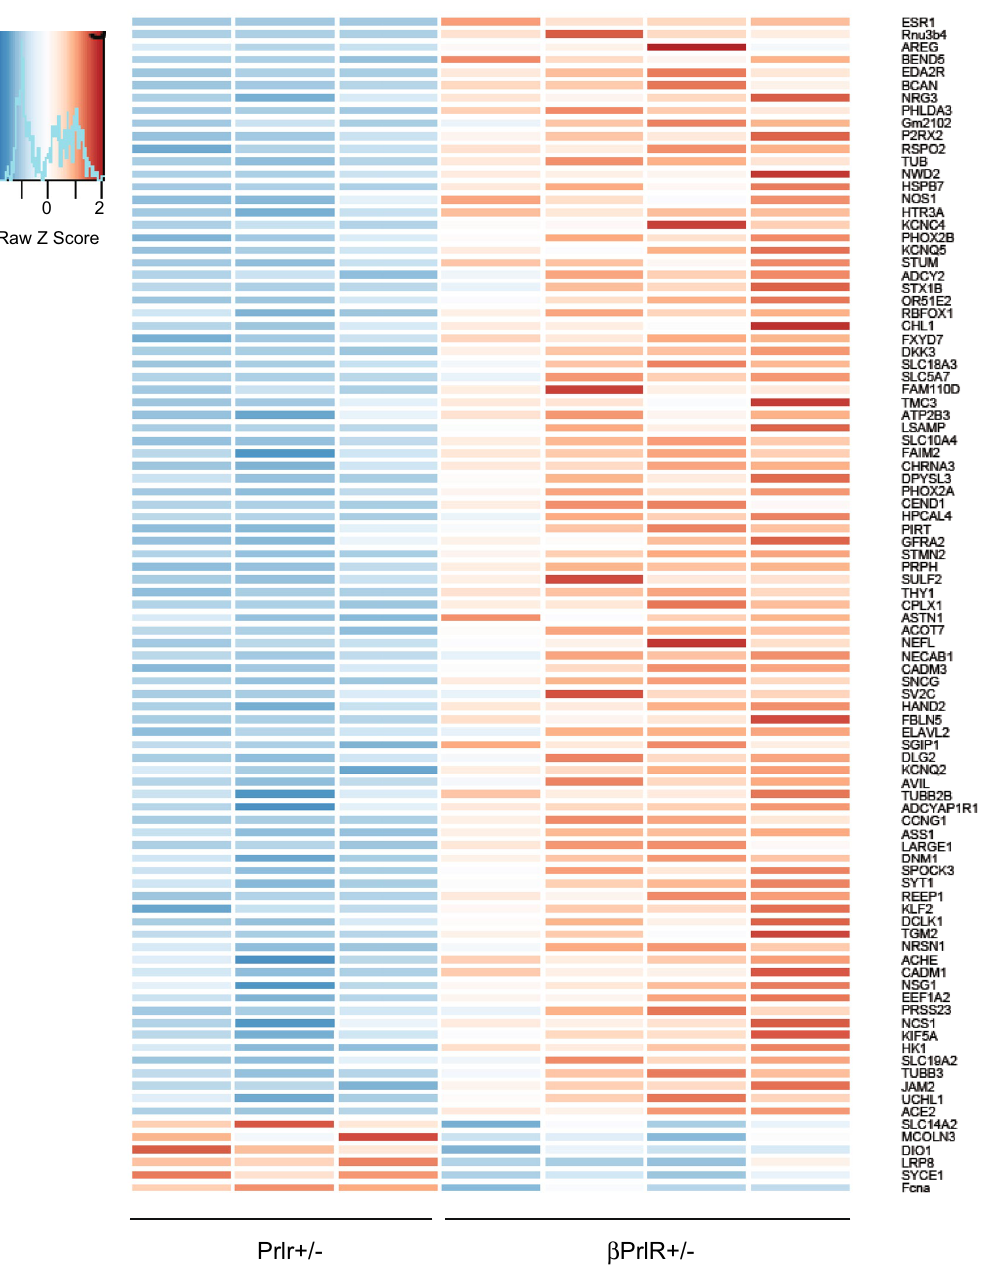
Figure 4. Heat map representing differentially expressed genes in islets from day 15 pregnant Prlr +/− versus βPrlR +/−